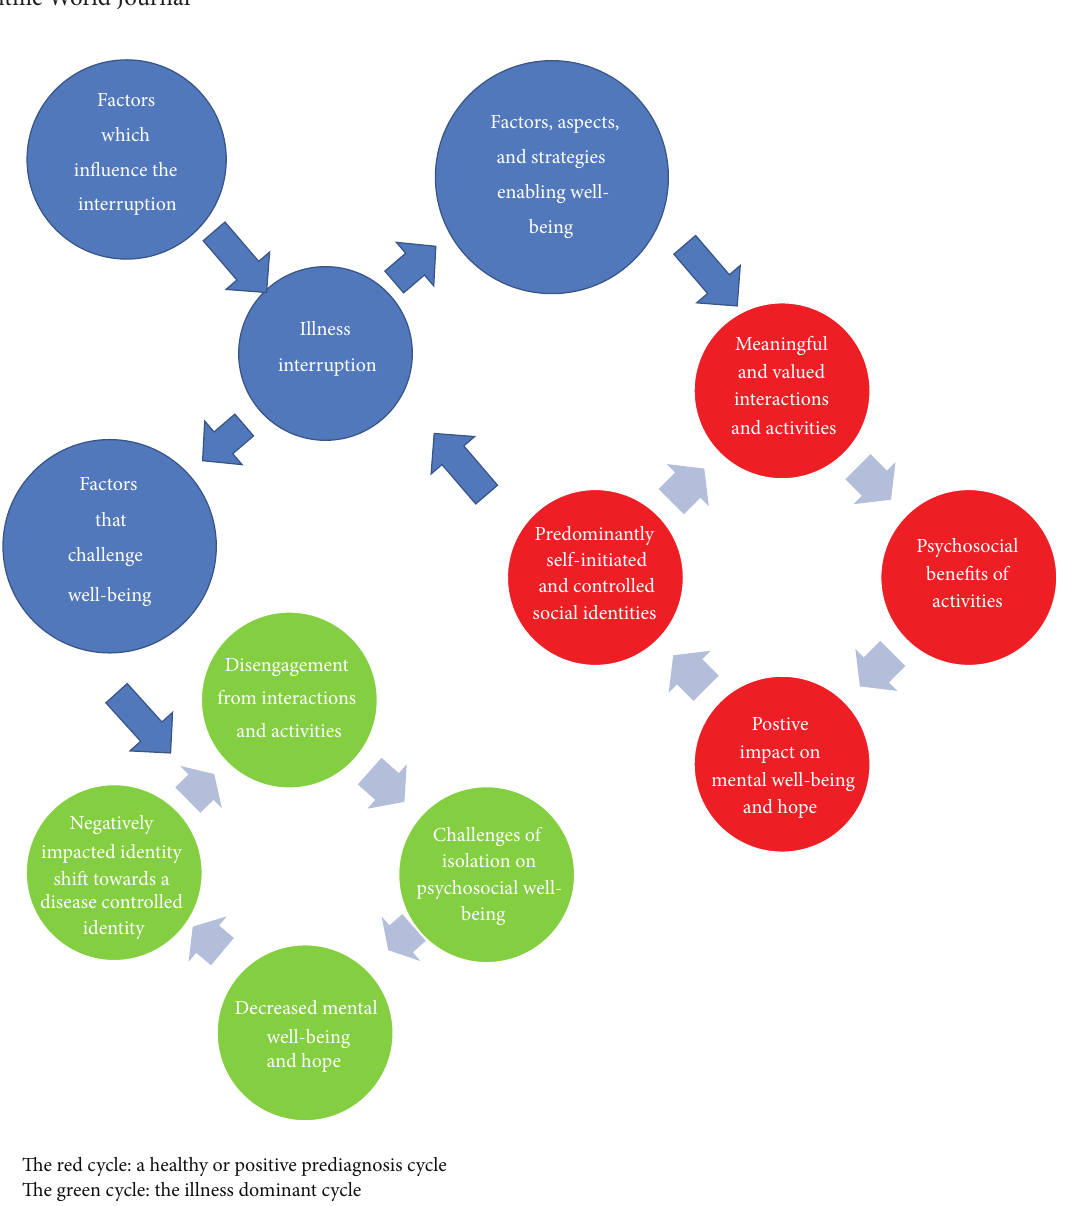
Figure 2: The model of hope